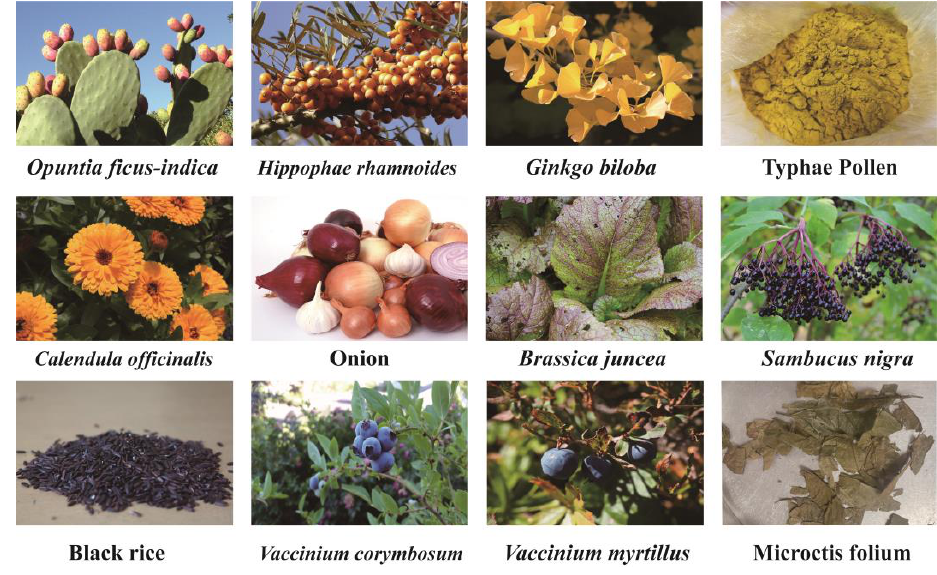
Figure 3. Plants with IG